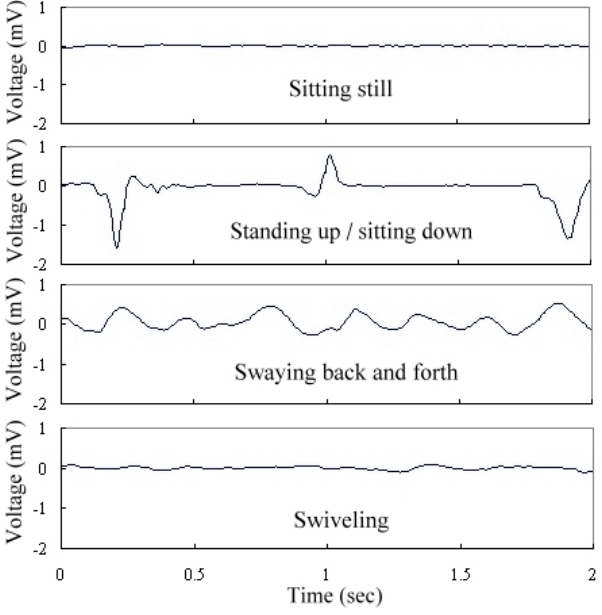
Figure 2. Waveforms of different movements.